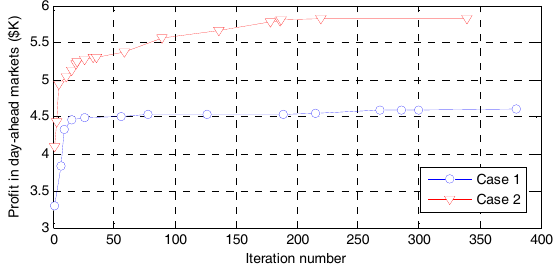
Figure 5. Computation performances for Cases 1 and 2.